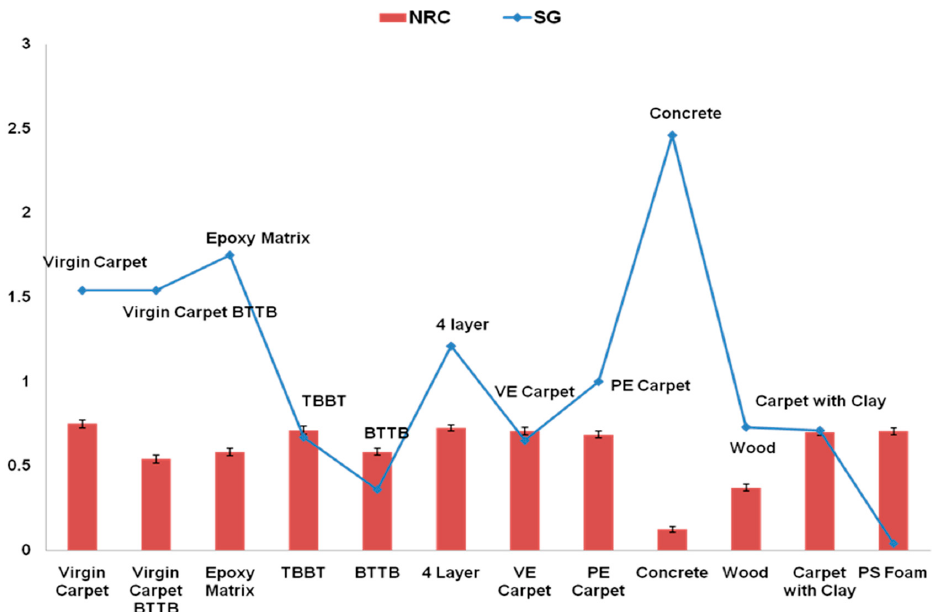
Figure 10. Correlation of noise reduction coefficients (NRC) with specific gravity (SG).